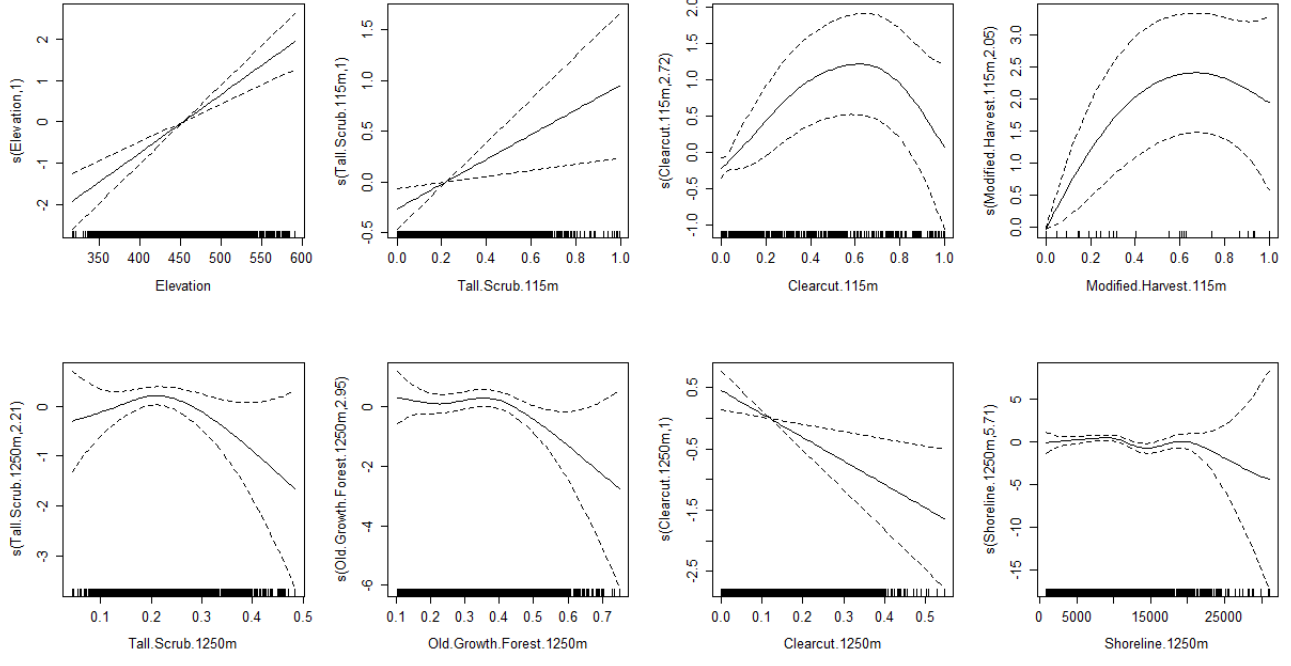
Fig. 4 . Fitted relations between probability of occurrence and the continuous explanatory variables contained in our best model of habitat use by Gray-cheeked Thrushes (Catharus minimus minimus) in the Main River watershed, 2006 and 2007 (see Table 2). Smoothed values are plotted on the scale of the linear predictor (not the response variable) and are zero centered; the number following the covariate name in the y-axis label indicates the degrees of freedom (i.e., complexity) of the smoothed curve, where 1 equals a straight line, 2 indicates a quadratic curve, etc. Rugs along the horizontal (x) axis of each plot depict the individual observations used to fit that factor (n = 1613). The rug along the horizontal axis of the mod.115 plot appears to have fewer observations because no modified harvesting occurred within 115 m of most survey points (i.e., there were 1589 observations having a value of zero).